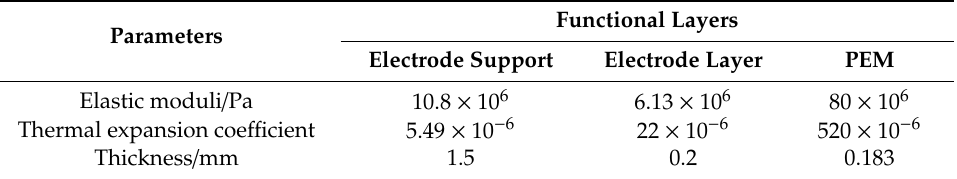
Table 2. Material performance